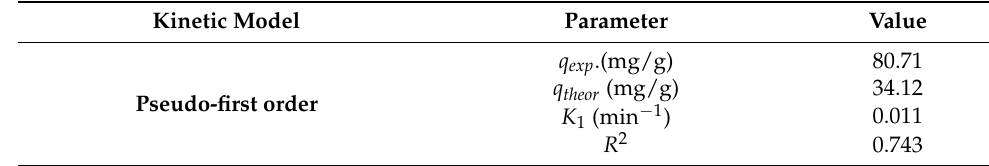
Figure 11. Kinetic models for diazinon adsorption onto MIP-202/CA composite beads. Table 2. Pseudo-first order, pseudo-second order, Elovich and intraparticle diffusion kinetic models for diazinon removal onto MIP-202/CA